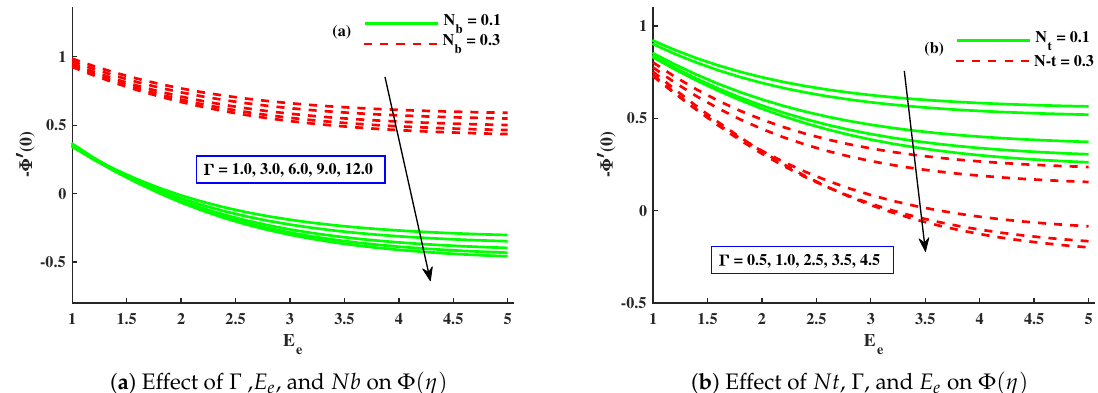
Figure 12. Curves of Φ ( η ) with Γ , Nb , Nt , and E e . Table 1. The comparison of F (cid:48)(cid:48) parameters values are zero.